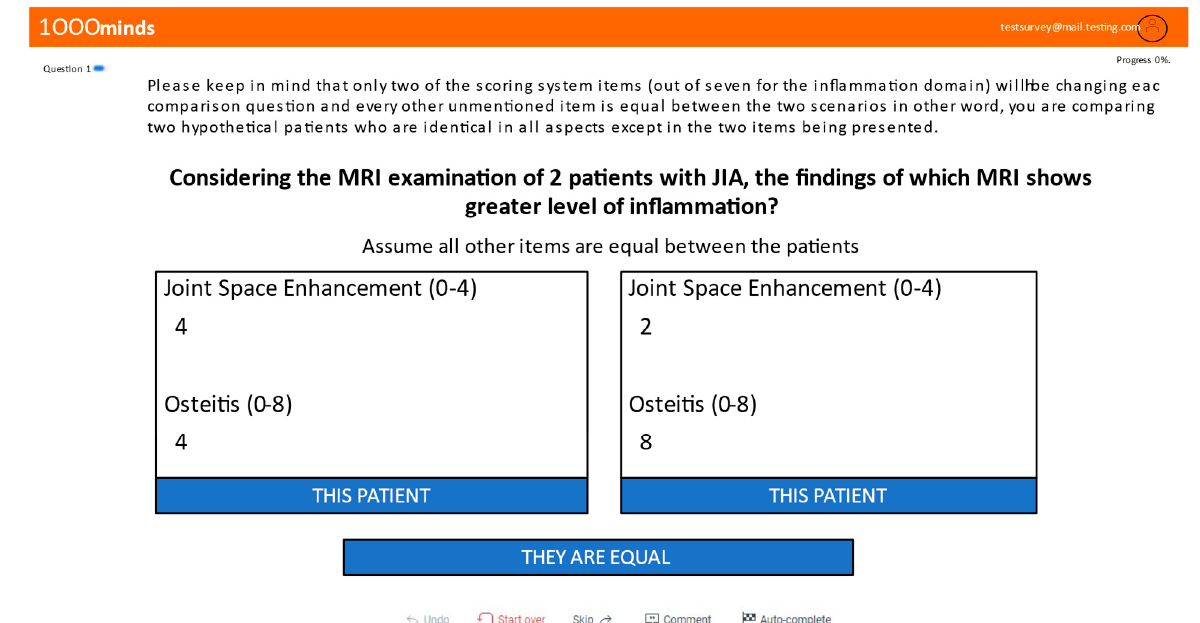
Figure A1. JAMRIS-SIJ inflammation domain item comparison. An example of an item comparison